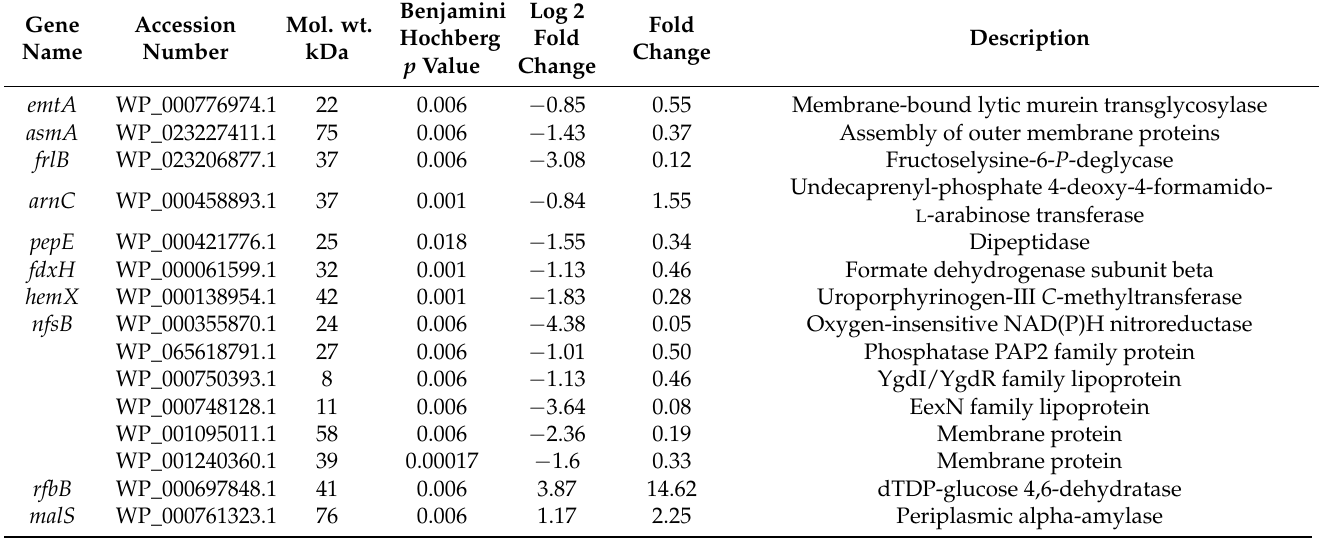
Table 2. Alteration of membrane-associated proteins in the S . Enteritidis ∆ cpxR mutant due to CHX